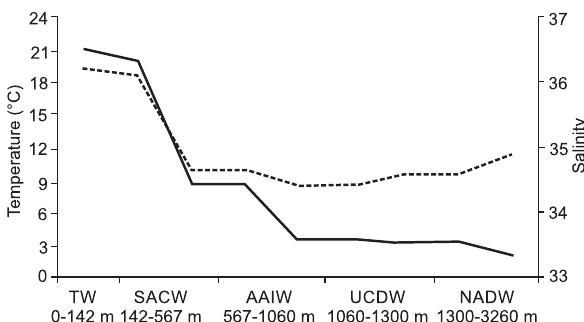
stations.C. Figure 1. Salinity and temperature of the five water masses (0–3260 m) in the Campos Basin, central Brazilian coast, modified from Bonecker et al. (2014). Solid line = temperature; dashed line = salinity; SS, Subsurface Water; SACW, South Atlantic Central Water; AAIW, Antarctic Intermediate Water; UCDW, Upper Circumpolar Deep Water; NADW, North Atlantic Deep Water. Figure 2. Study area showing sampling ZOOLOGIA 35: e13886 | DOI: 10.3897/zoologia.35.e13886 | April 16, 20182 /